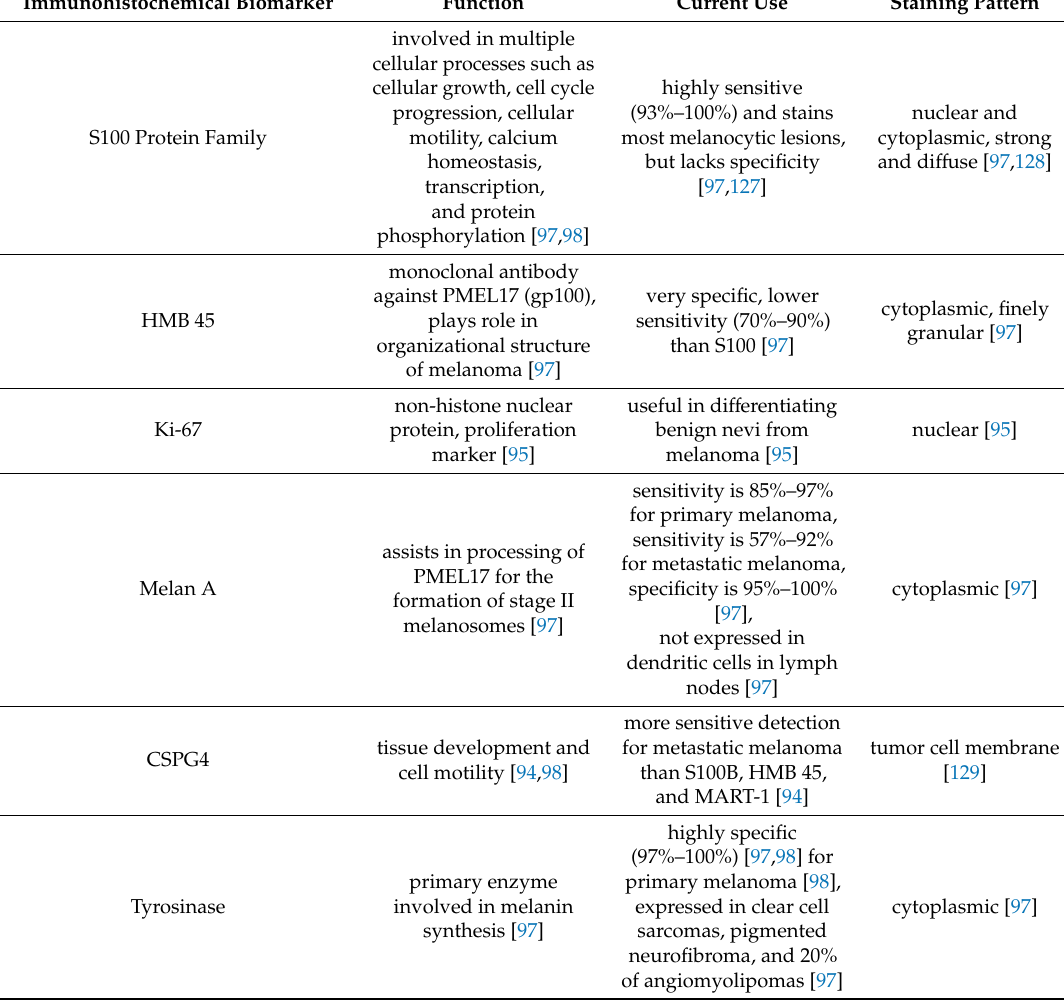
Table 2. Immunohistochemical biomarkers with their function, current use, and staining